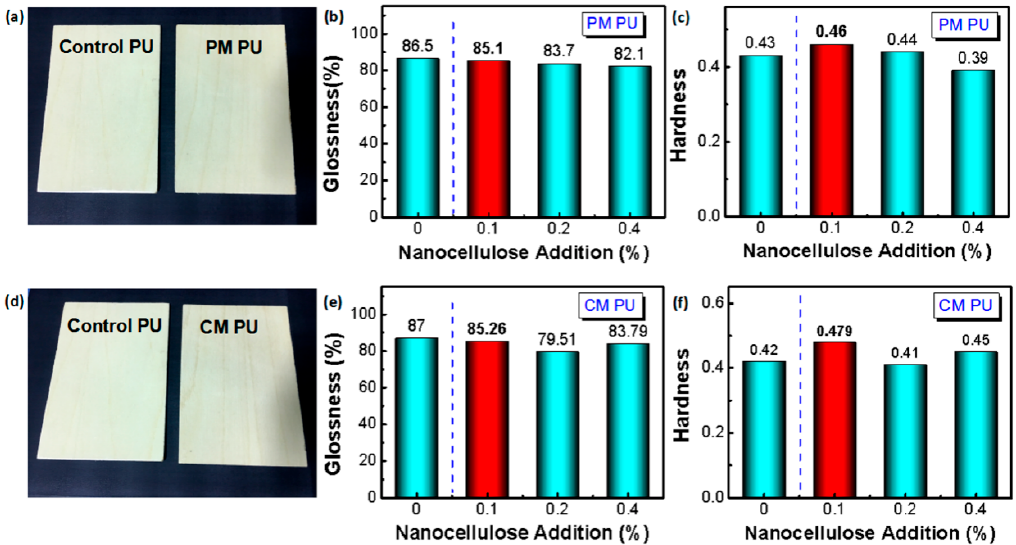
Figure 4. Comparison of glossiness and hardness of the PU film as wood coating with/without nanocellulose addition. ( a ) Comparison of the appearances of the control and the PM PU wood coating with 0.1wt% nanocellulose addition; ( b ) Comparison of the glossiness of the PM PU films with different nanocellulose additions; ( c ) Comparison of hardness of the PM PU films with different cellulose contents; ( d ) Comparison of the appearance of the control and the CM PU wood coating with 0.1wt% nanocellulose addition; ( e ) Comparison of the glossiness of the CM PU films with different nanocellulose contents; ( f ) Comparison of hardness of the CM PU films with different nanocellulose contents.